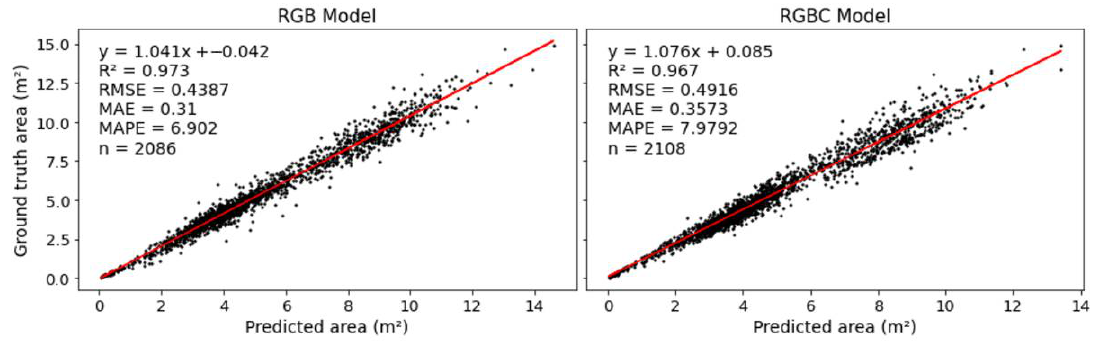
Figure 12. Linear regression results pafor crown area.